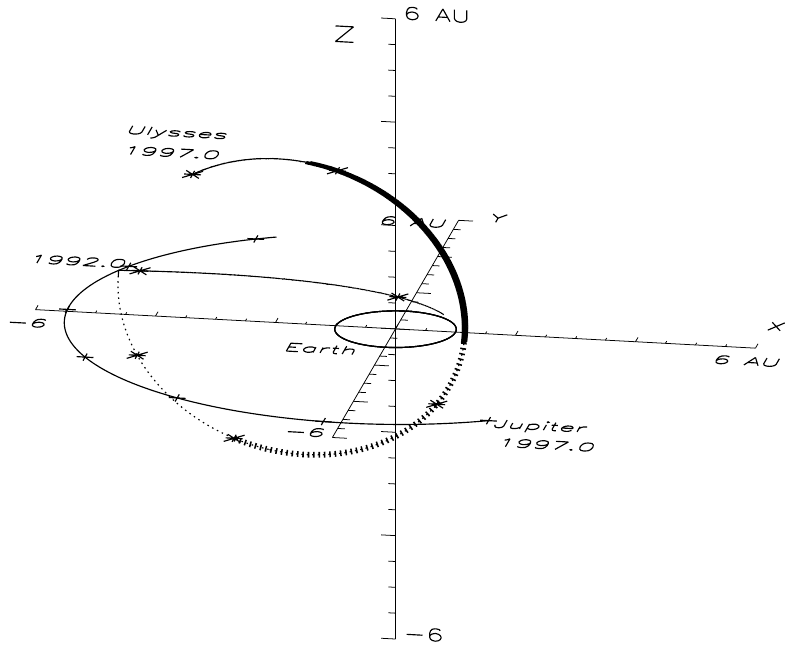
Fig. 1. Trajectories of Ulysses and Jupiter. The heavy line represents the trajectory of Ulysses during the period of the